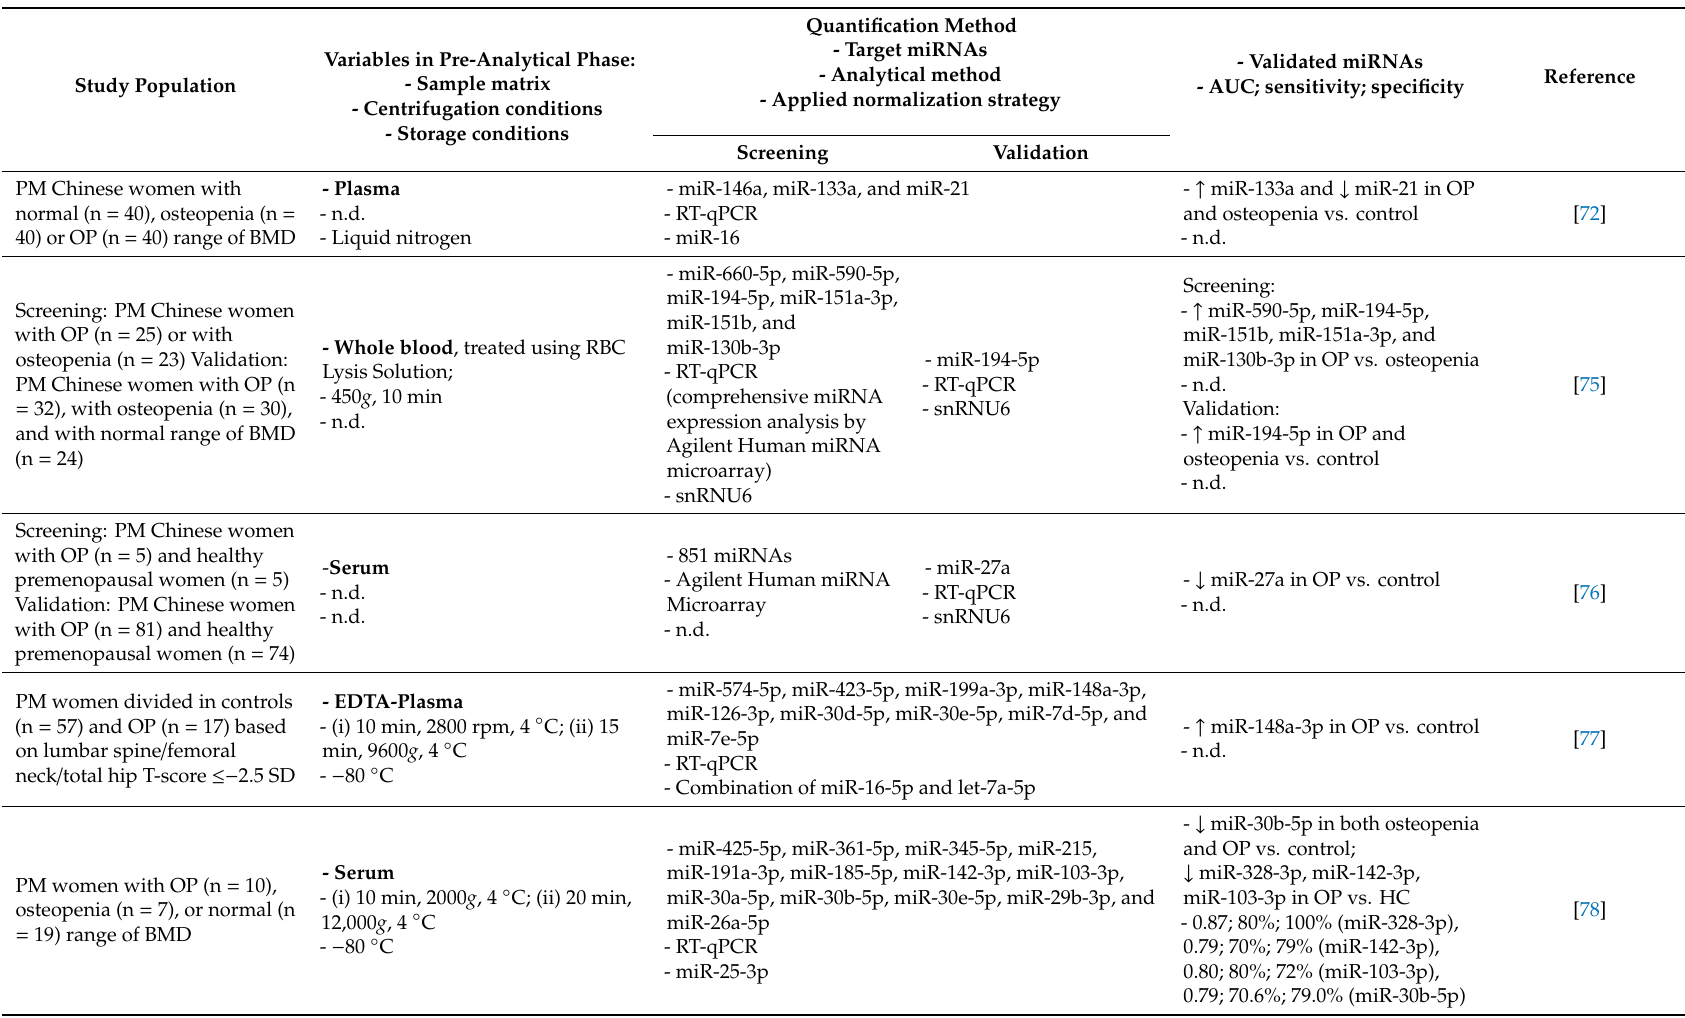
Table 1. Circulating microRNAs (miRNAs) in pre- and postmenopausal osteoporosis (PM